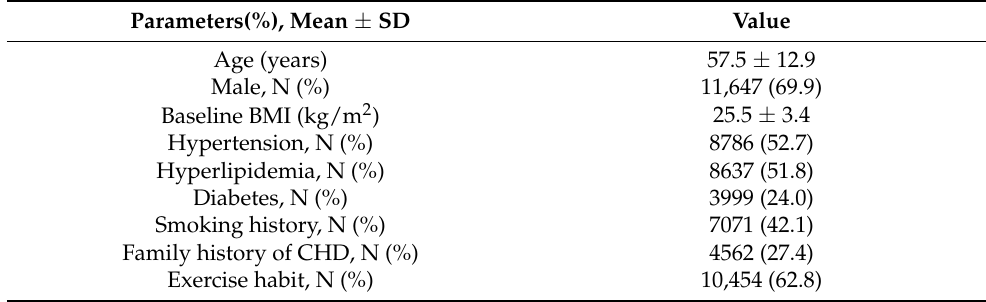
Abbreviation: BMI, body mass index. CHD, coronary heart